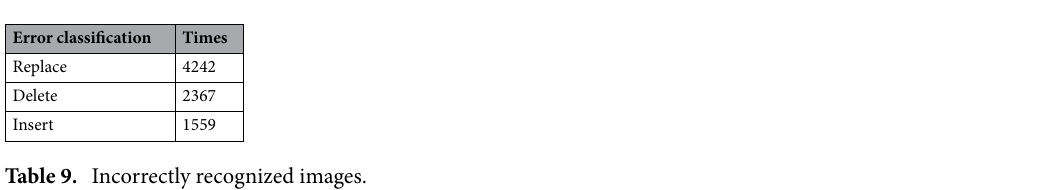
Table 9. Incorrectly recognized